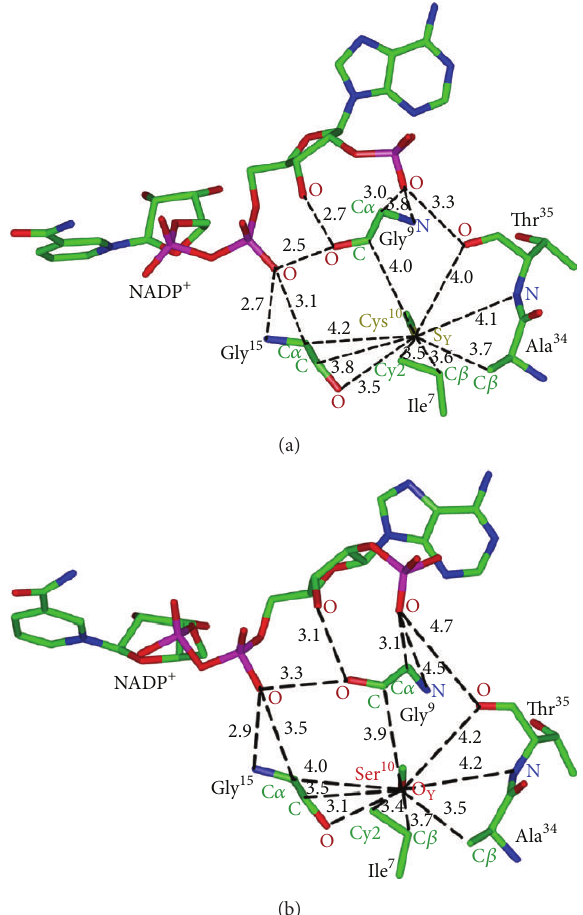
Figure 2: Position of Cys 10 in wild-type 17 𝛽 -HSD1 and of Ser 10 in mutant 17 𝛽 -HSD1. Cys 10 has stabilizing interactions with neighbor- ing residues involved directly in the binding of cofactor NADPH. A , wild-type 17 𝛽 -HSD1. Cys 10 has van der Waals contacts with Ile 7 , Gly 9 , Gly 15 , Ala 34 , and Thr 35 . Gly 9 , Gly 15 , and Thr 35 contact NADP + . B , Cys 10 Ser mutant 17 𝛽 -HSD1. Ser 10 has van der Waals contacts with Ile 7 , Gly 9 , Gly 15 , Ala 34 , and Thr 35 . The backbone nitrogen on Gly 9 and the backbone oxygen on Thr 35 no longer contact the oxygen on the adenosine phosphate.